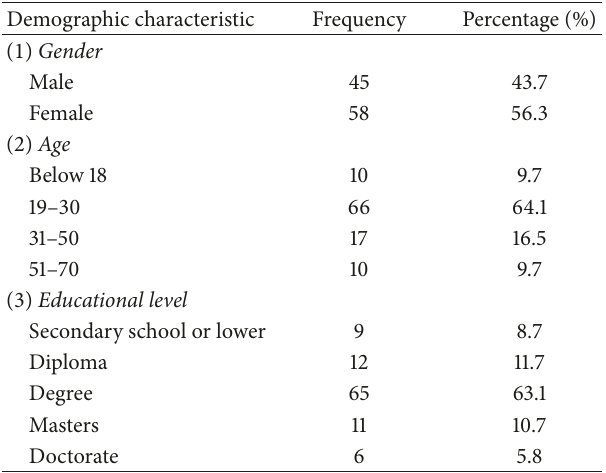
Table 2: Demographic profiles of